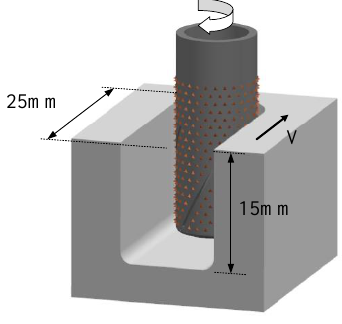
Figure 6. Polarization curve of Ti6Al4V in 10% NaNO 3 .